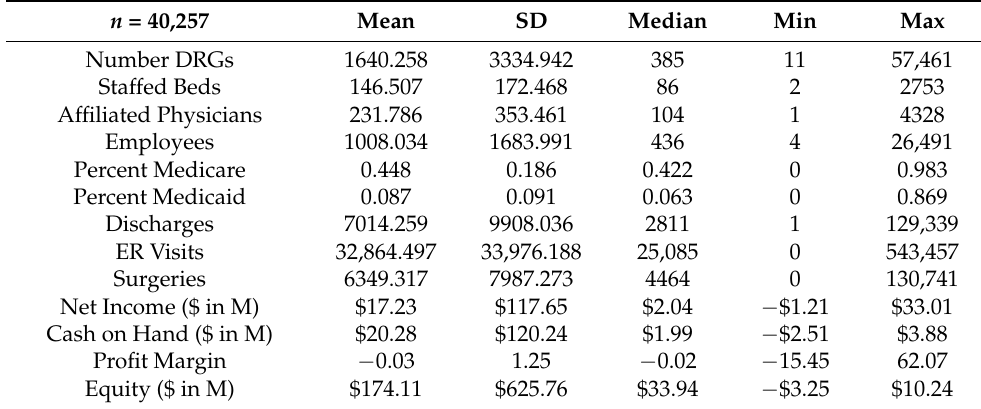
Table 2. Descriptive statistics for the study (dollars in